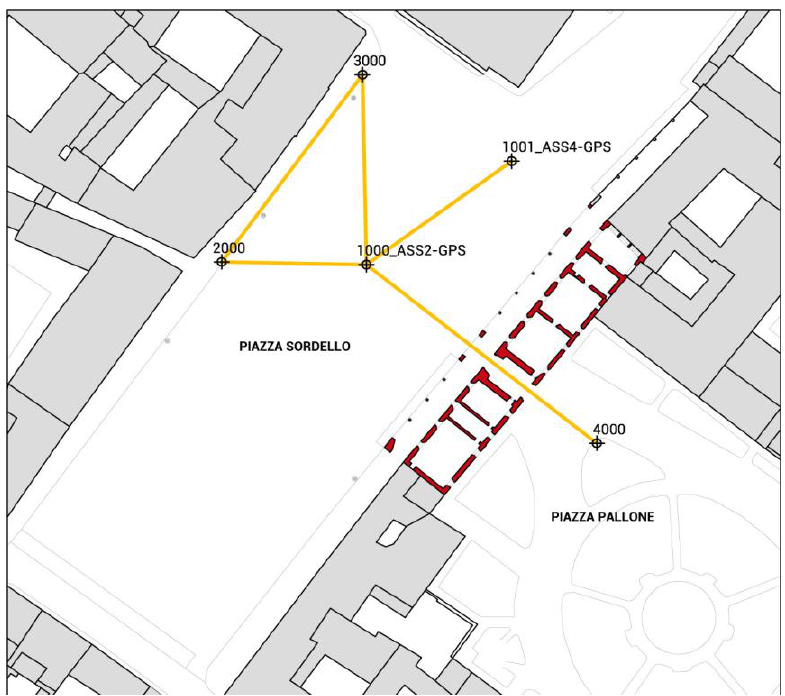
Figure 11. Plan of the topographic network with the localization of